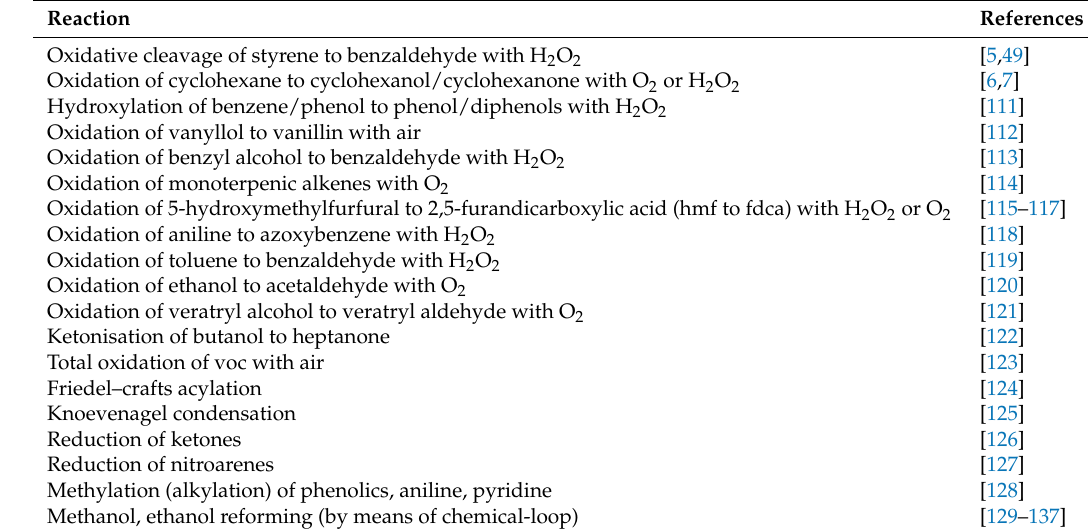
Table 2. Applications of spinel mixed-metal oxides as